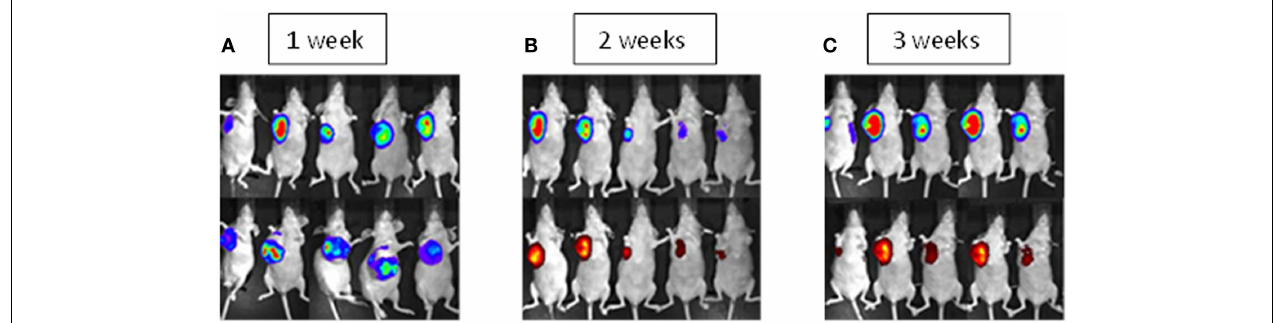
3weeks after completion of three doses of intravenous MSCs where tumor starts to re-grow.The top panel shows no difference in primary tumor size when compared to control animals.The bottom panel indicates that the MSCs preferentially migrated to and engrafted at the site of chest wall tumors. Luciferase reporter from Ewing’s sarcoma cells show as intensity gradient from low to high cell load indicated by blue to red. Quantity of quantum dot labeled MSCs indicated by intensity of red color in bottom panel.